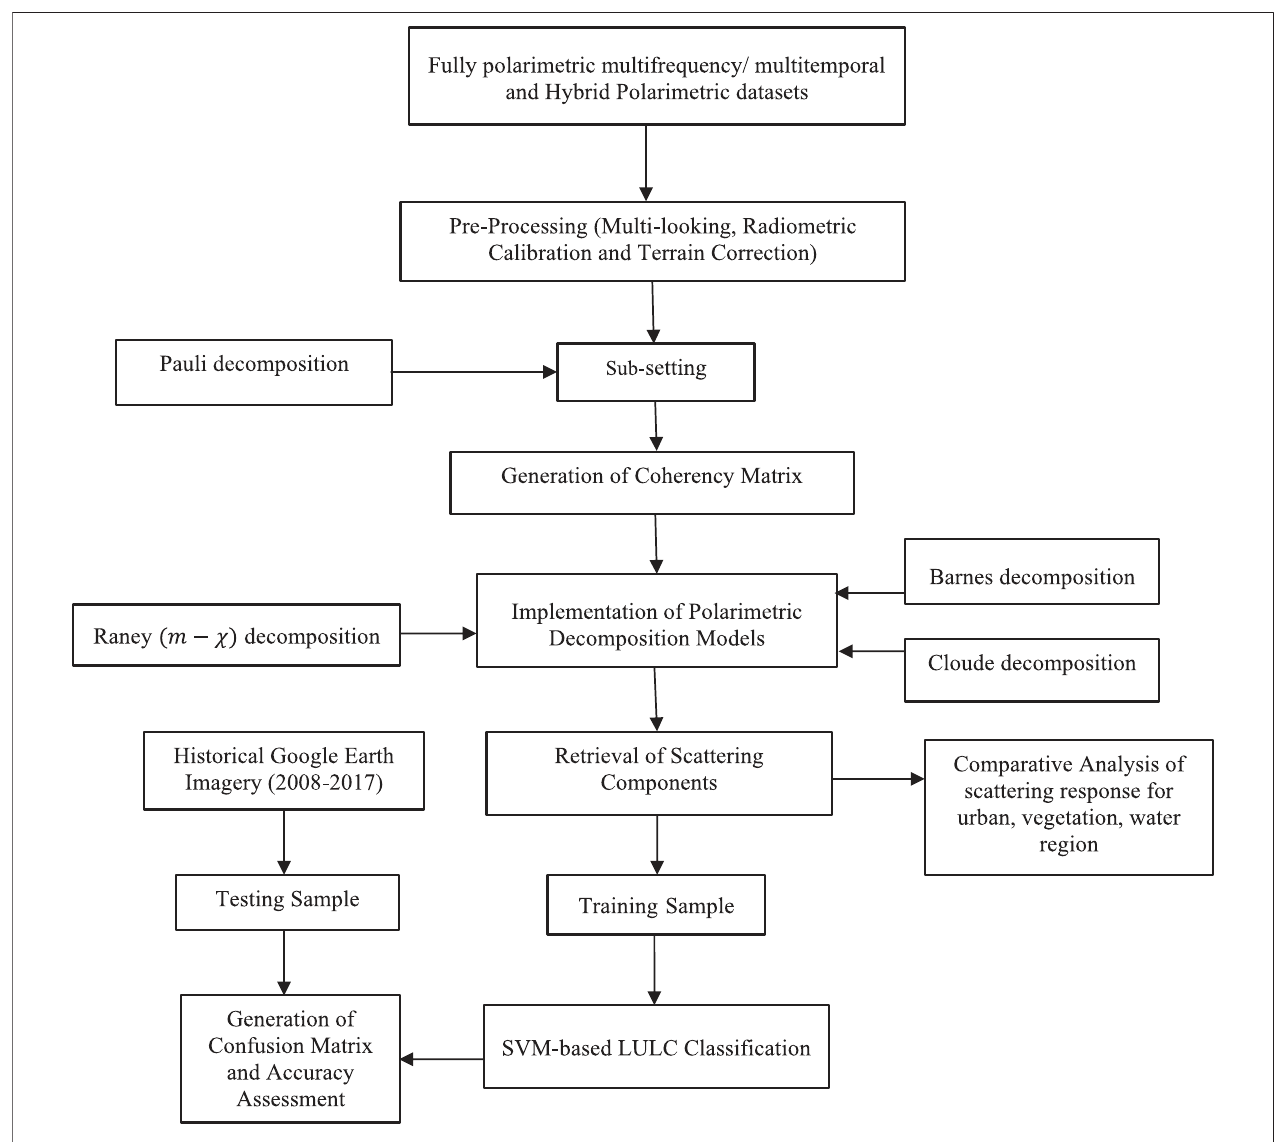
FIGURE 2 | Methodology fl